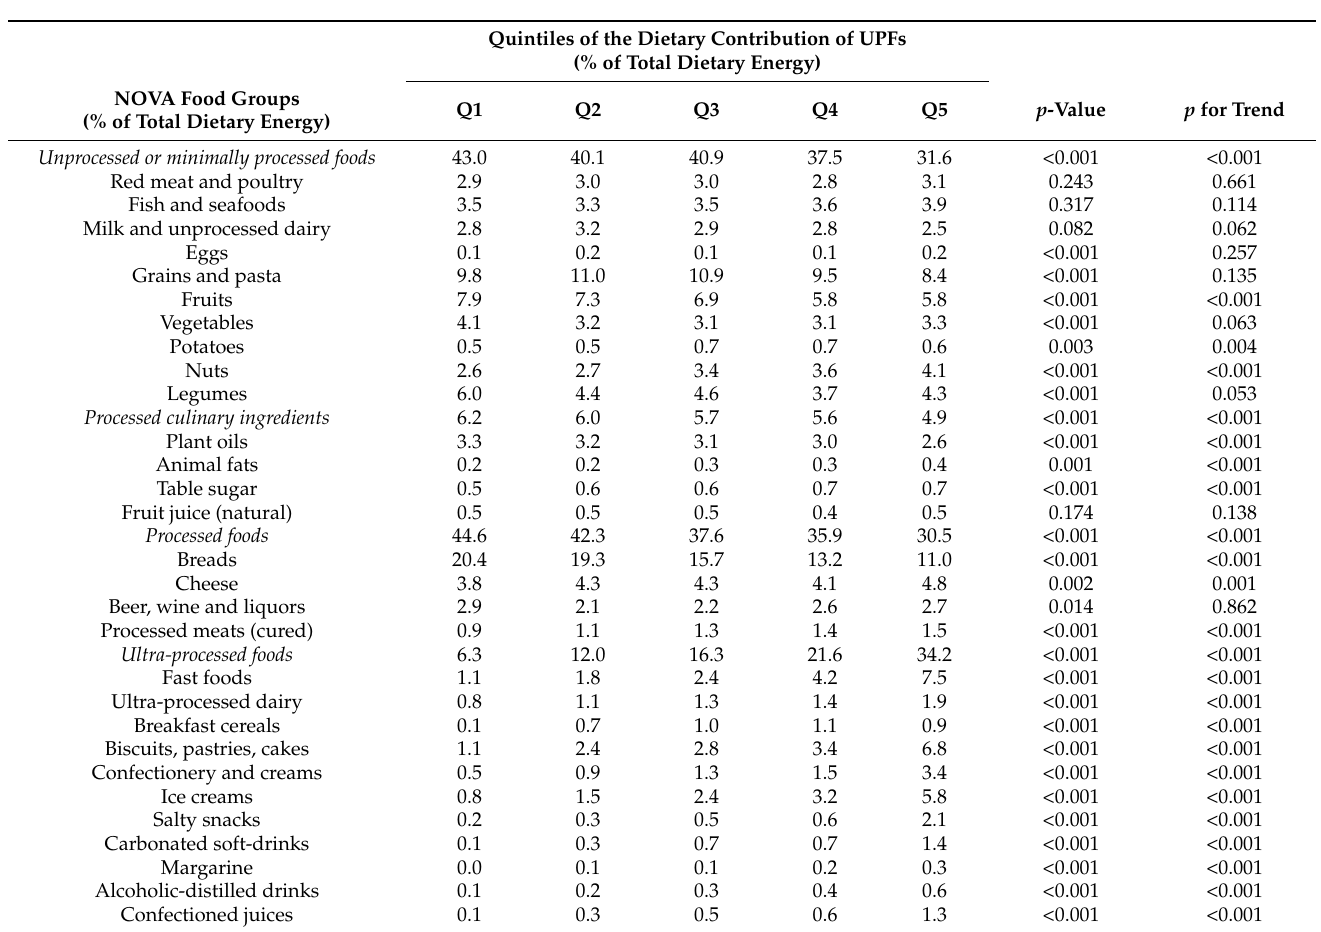
Table 2. Percentage of energy shares of NOVA food groups across quintiles of the daily energy share of UPFs in the study sample ( n =